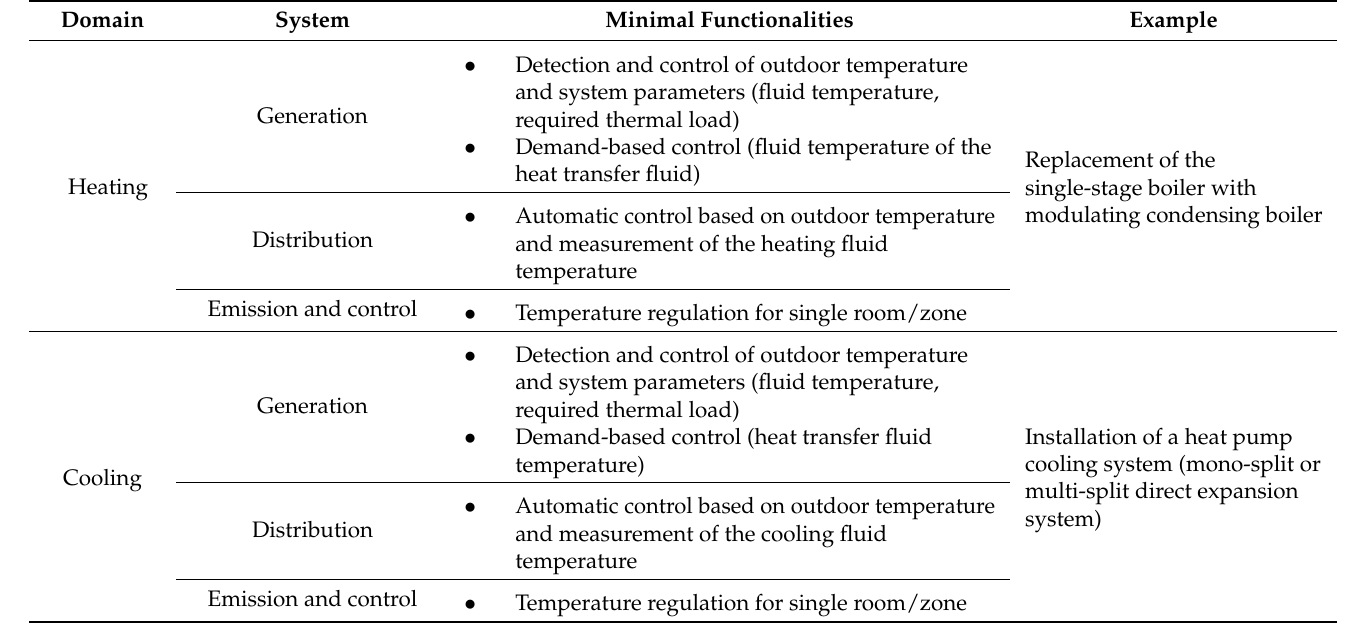
Table 4. Functionality levels of the “energy